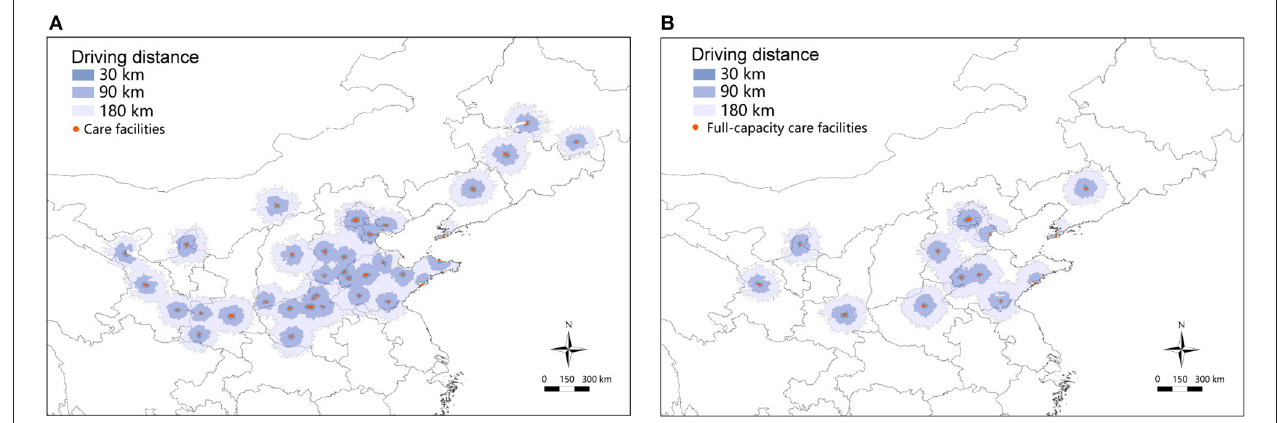
FIGURE 2 | Service areas of facilities for CHS in northern China. (A) Service area of all care facilities for CHS. (B) Service area of full-capacity care facilities for CHS. The shaded area with different colors indicates different drive distance. A drive distance of < 30km suggests a typical half-day visit, < 90km a typical 1 day visit, < 180km a probable overnight visit, and > 180km suggests at least one overnight stay. CHS, congenital heart surgery.